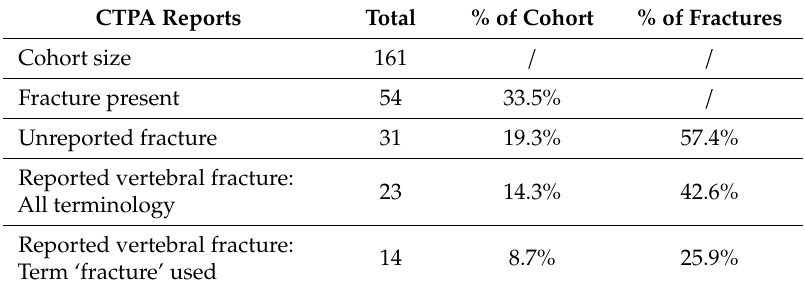
Table 1. Computerized tomography pulmonary angiograms (CTPA) reports and fracture incidence.